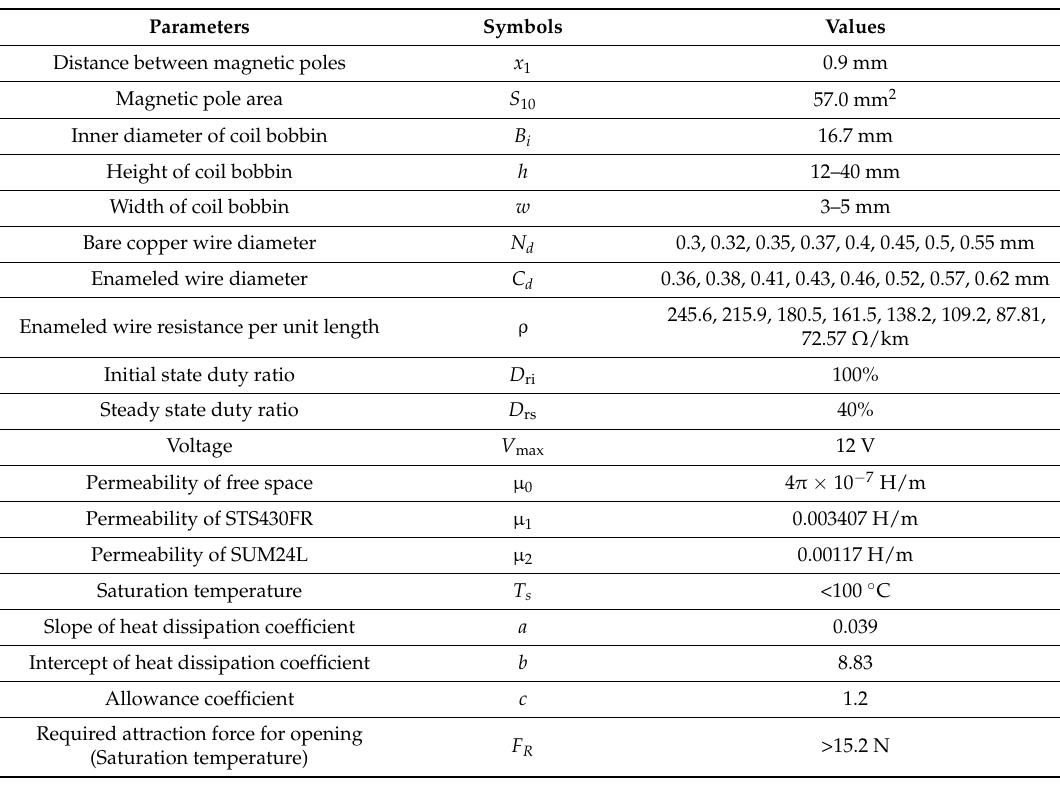
Table 1. Design parameters of solenoid